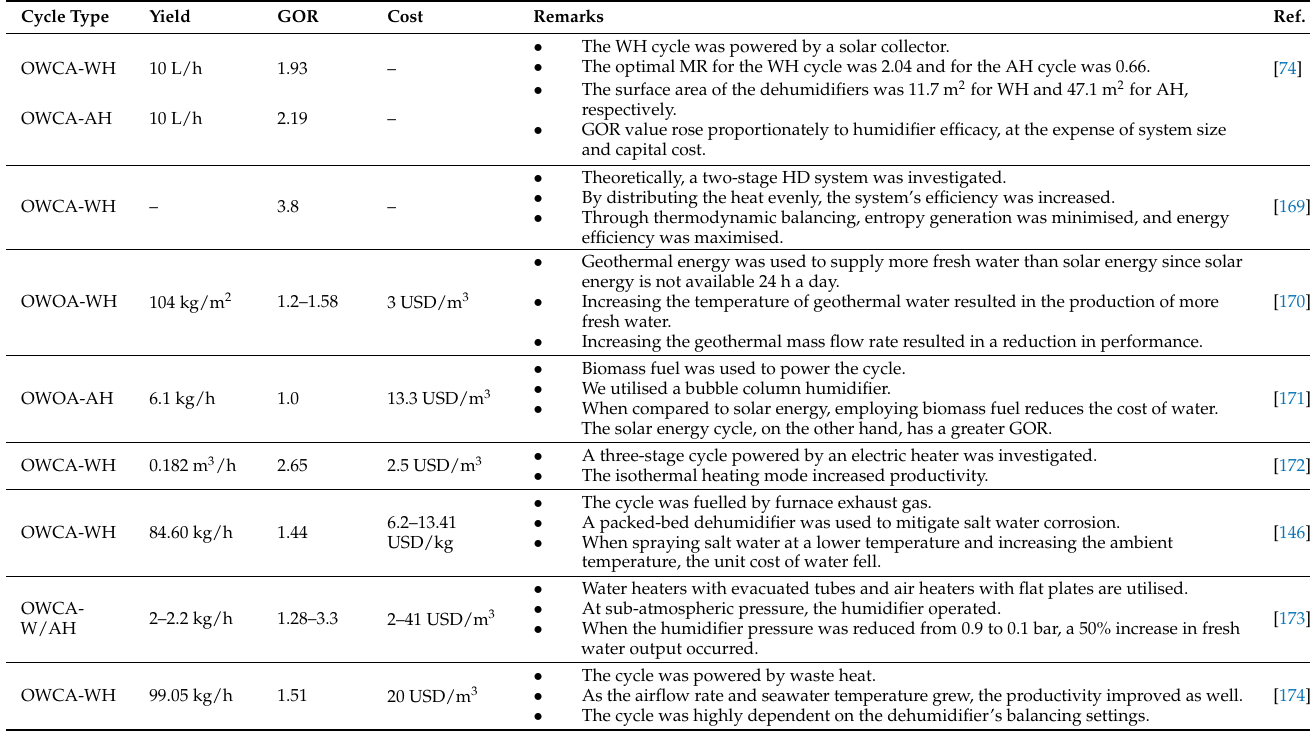
Table 4. Previous studies on HD